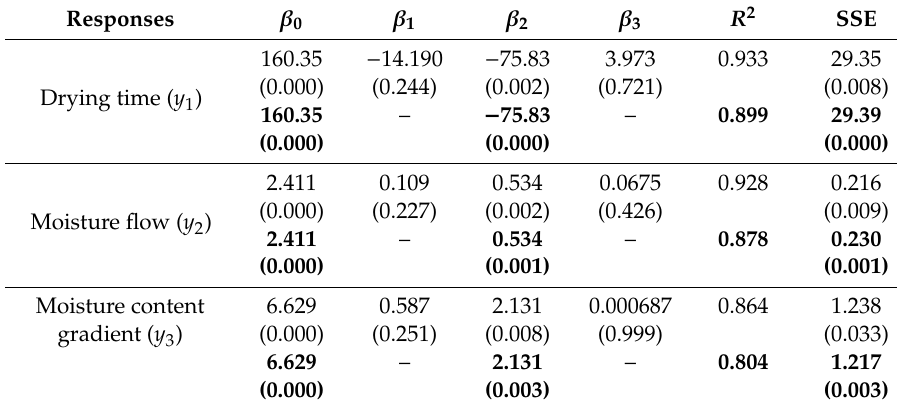
Table 6. Estimated coe ffi cients of the RSM